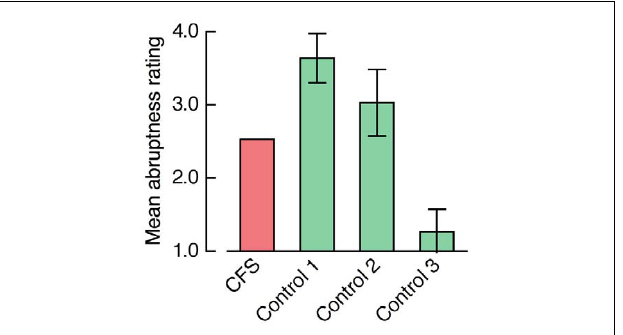
FIGURE 11 | Rating of subjective face appearance in Experiment 4. Bar plots denote participants’ mean ratings of the abruptness of face appearance (from 1 abrupt to 4 gradual). “Control 1” refers to the 8.5-s ramp, “Control 2” refers to the 2.5-s ramp, and “Control 3” refers to the no-ramp control condition. Positive and negative error bars represent 95% confidence intervals for the paired comparison between the CFS condition and the respective control condition.